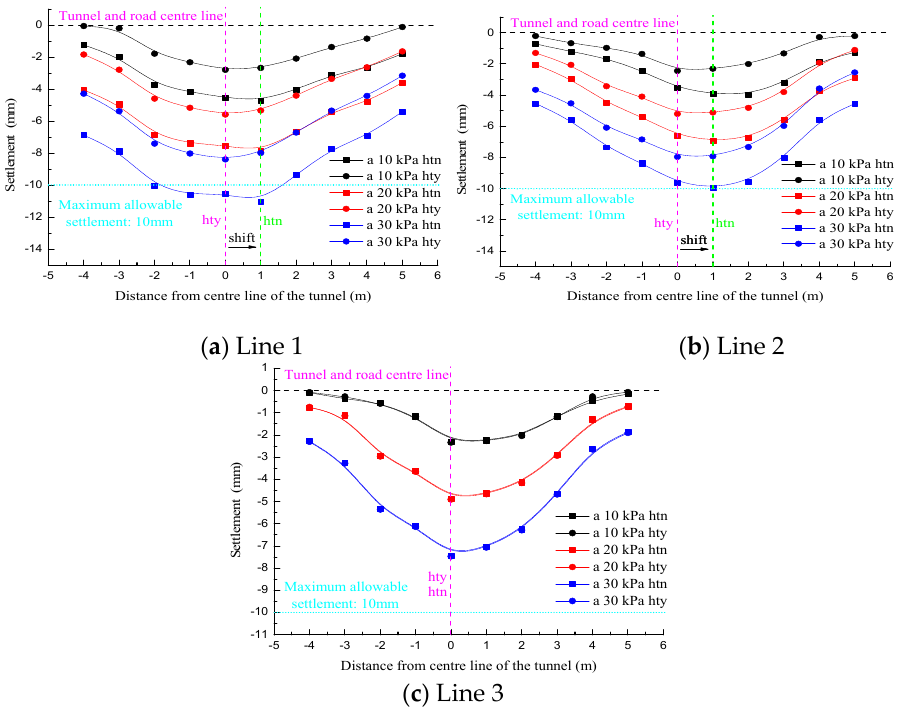
Figure 11. Longitudinal surface settlement of model A-A with D/W = 0.378.